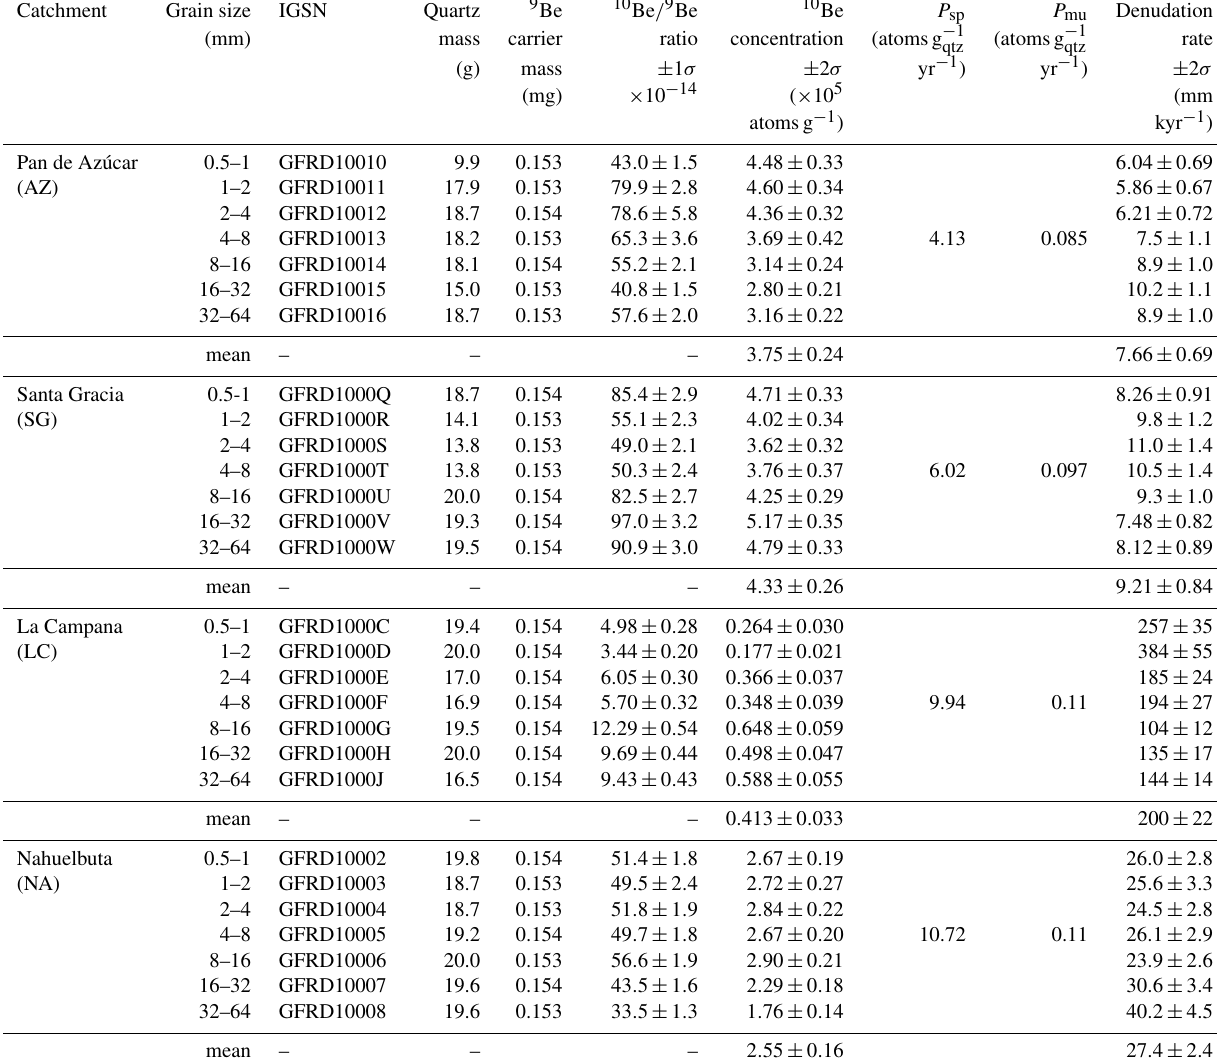
Table 2. Cosmogenic nuclide samples from the Chilean Coastal Cordillera. IGSN number, analysed quartz mass, 9 Be carrier mass, 10 Be / 9 Be ratio ( ± 1 σ ), 10 Be concentrations ( ± 2 σ analytical error), spallation ( P sp ) and muogenic ( P mu ) production rates, and calculated denudation rates ( ± 2 σ